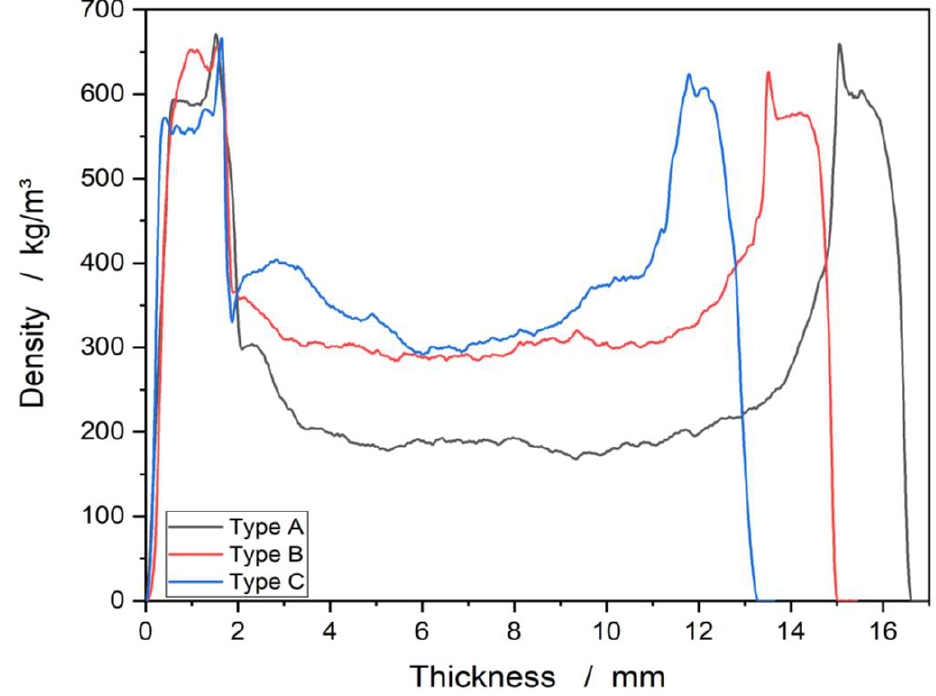
Figure 3. Density profile across the panel cross-section.